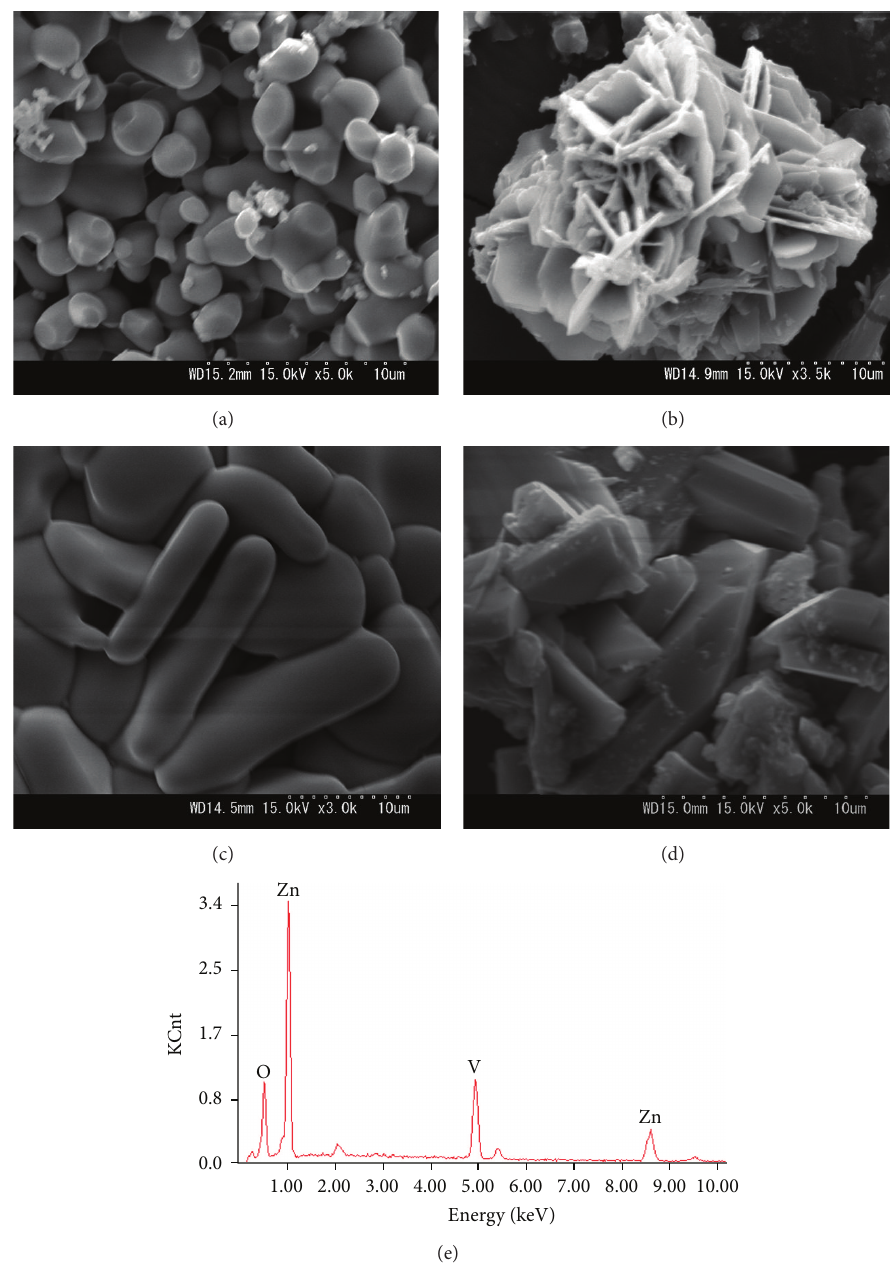
Figure 7: SEM micrographs of the Zn 3 V 2 O 8 phosphor synthesized at 775 ∘ C by different methods: (a) combustion, (b) hydrothermal, (c) gel-combustion, (d) solid state, and (e) typical EDX profile coupled with